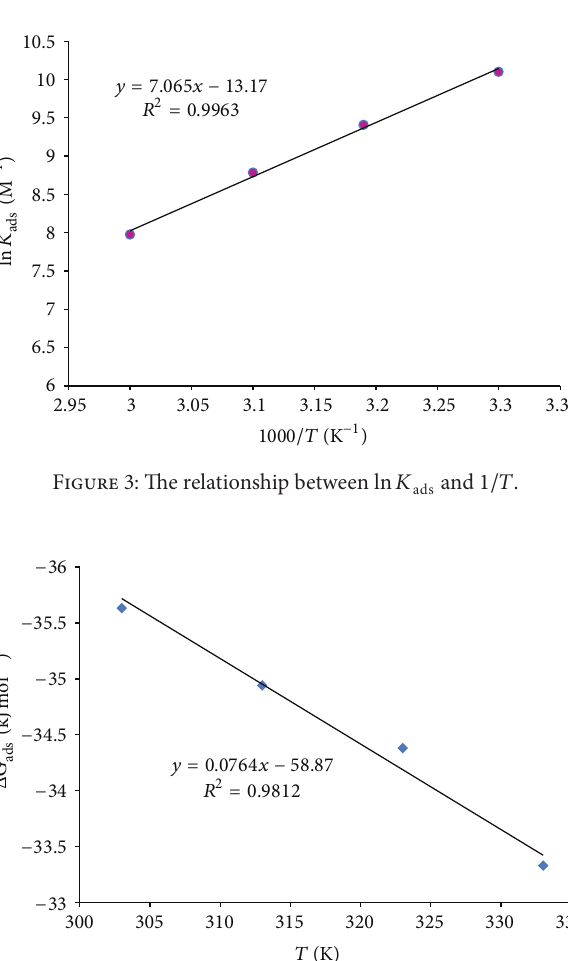
of RS and temperature (𝑇) . ads